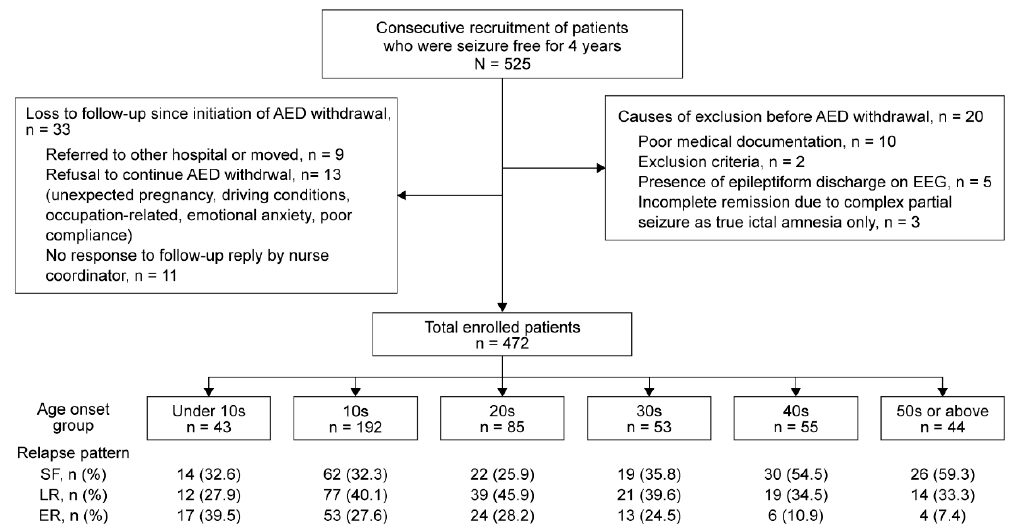
Figure 1. Flowchart of the recruitment process for the inclusion of patients. A total of 525 epilepsy patients were initially recruited, and 53 patients were excluded due to the above documented causes. Finally, 472 patients were grouped into 10-year age groups according to the age of onset and